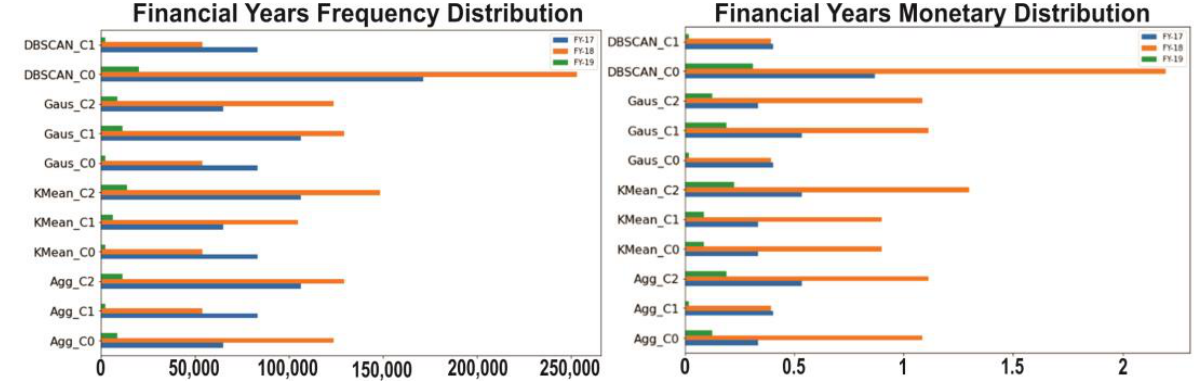
Figure 7. Financial year wise frequency, monetary distribution on different clusters, and algorithms.